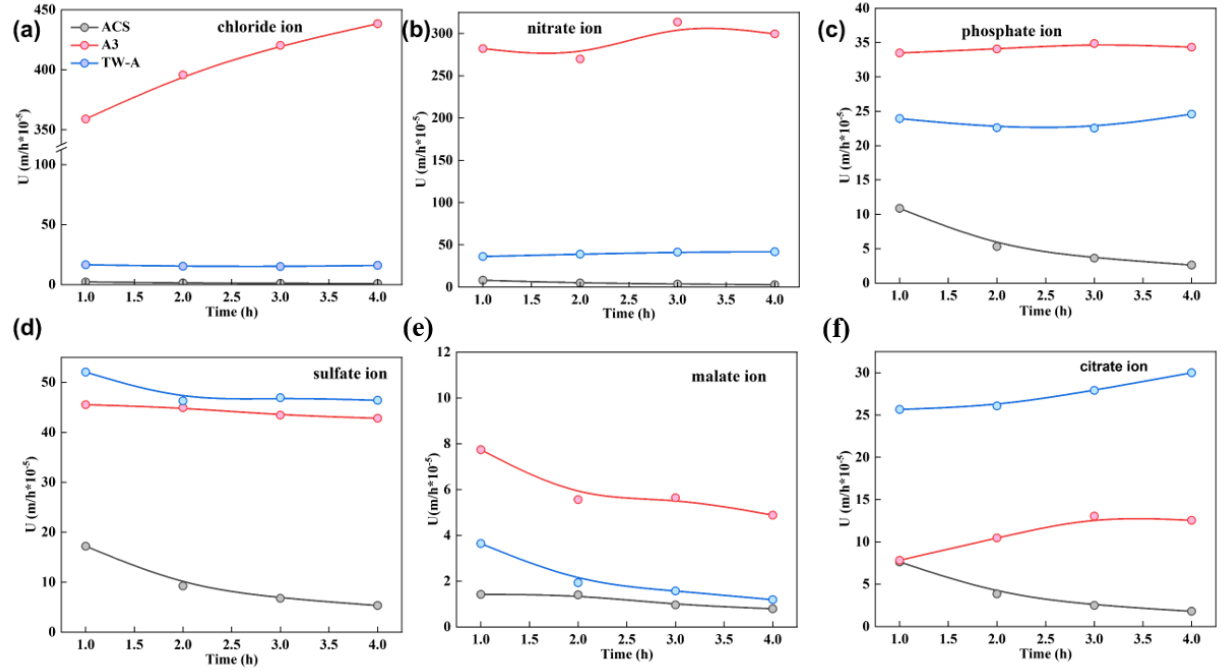
Figure 3. Permeation coefficients of ( a ) Chloride ion; ( b ) nitrate ion; ( c ) phosphate ion; ( d ) sulfate ion; ( e ) malate ion, and ( f ) citrate ion versus time during static diffusion dialysis experiment.